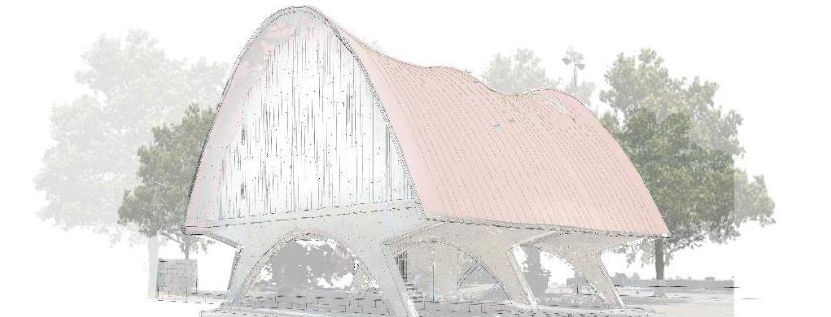
Figure 1. HBIM rendering of Cosmic Rays Pavilion based on the point cloud data (Drawn by Rajabzadeh,